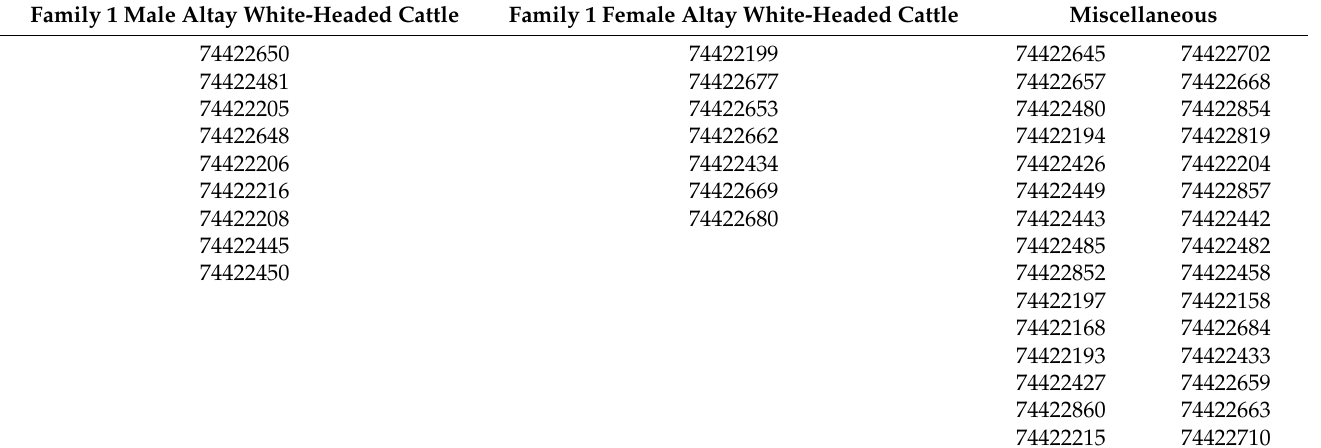
Figure 6. Principal component analysis results.